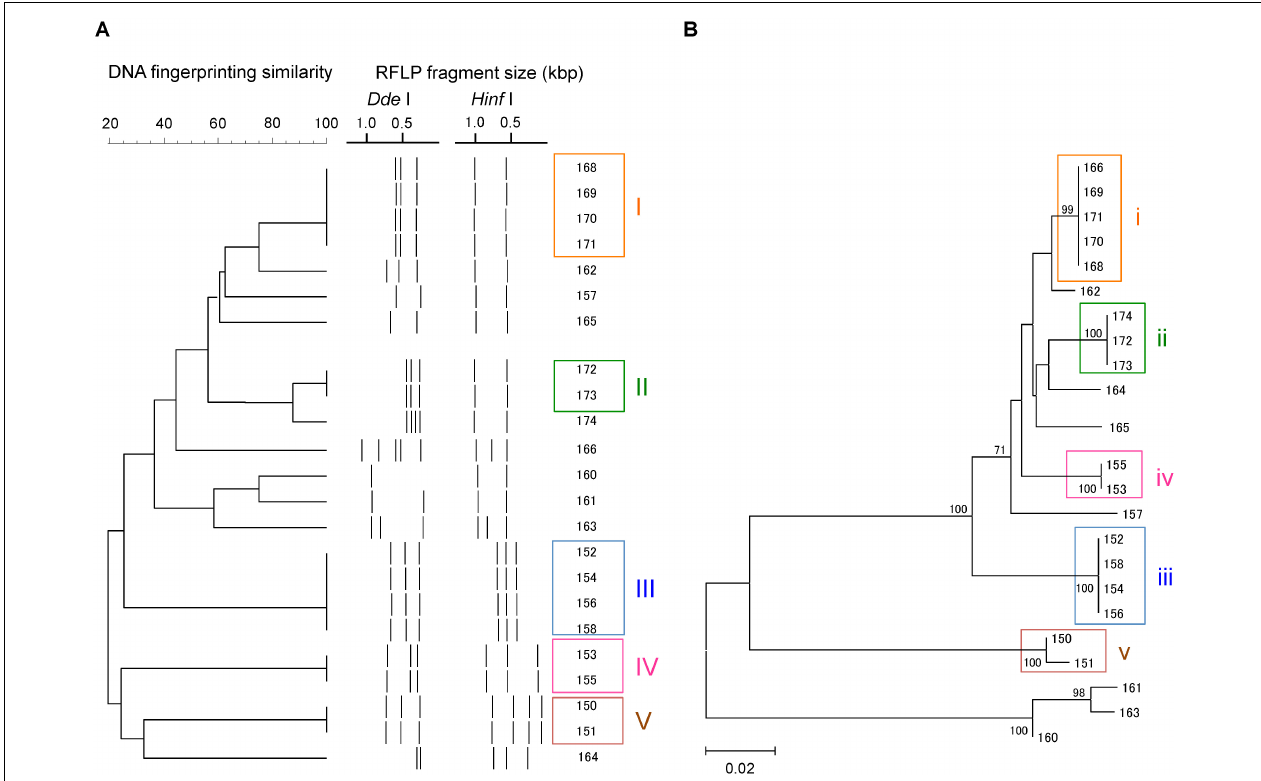
FIGURE 1 | Clustering patterns of the Campylobacter strains isolated in this study, based on (A) flaA RFLP and (B) flaA SVR sequencing. Clustering was done using UPGMA method for flaA RFLP, while maximum likelihood method was used for flaA SVR sequencing.